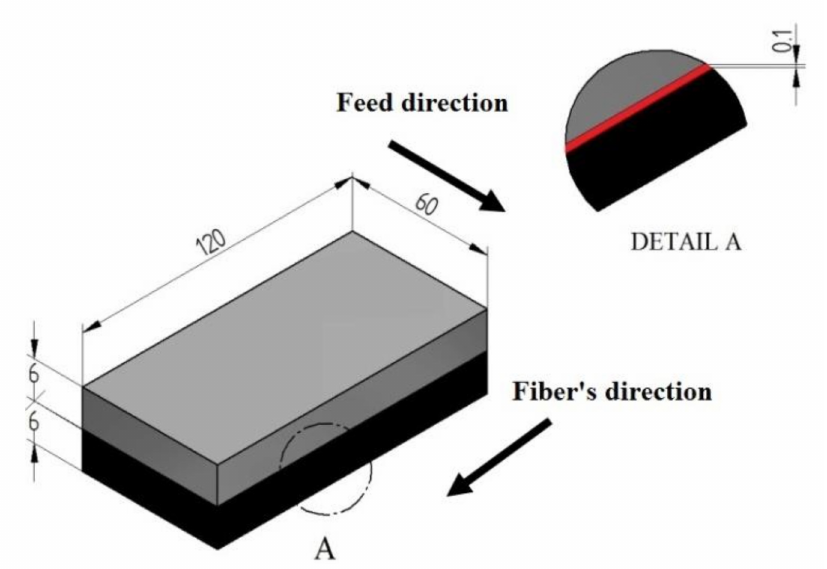
Figure 1. Sample shape and